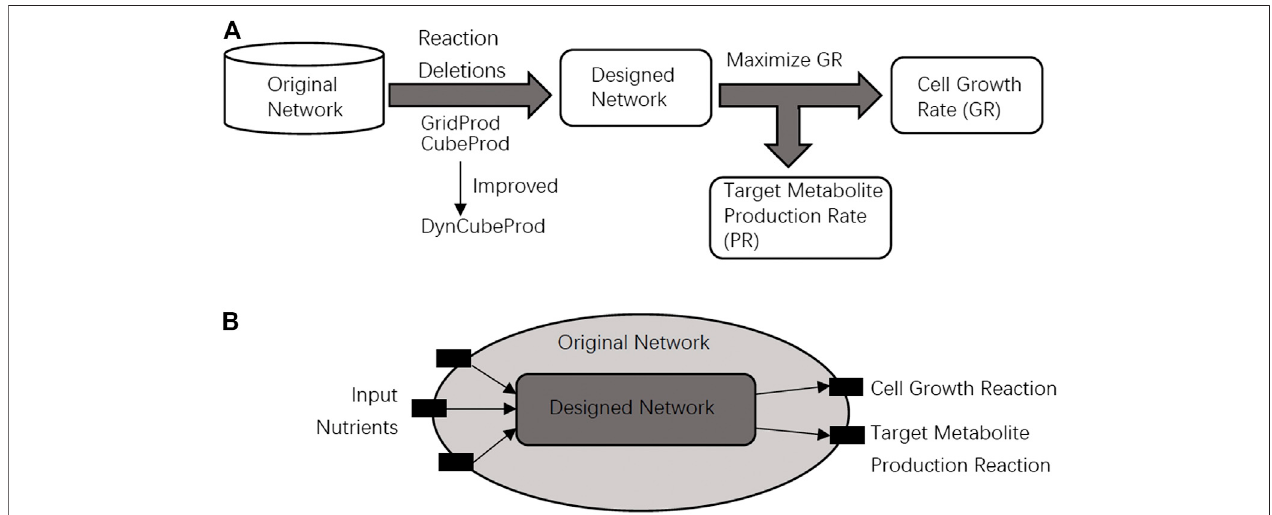
FIGURE 1 | (A) In the problem setting of this study, it is required that the original network is converted into the designed network that achieves growth coupling, where cell growth and target metabolite production are simultaneously achieved. (B) The designed network should be obtained from the original network through reaction deletions. The black blocks are nutrient uptake reactions, the cell growth reaction, or the target metabolite production reaction. The speed of the cell growth reaction and target metabolite production reaction are represented by GR and PR, respectively. Light gray and dark gray represent the designed network and the original network,